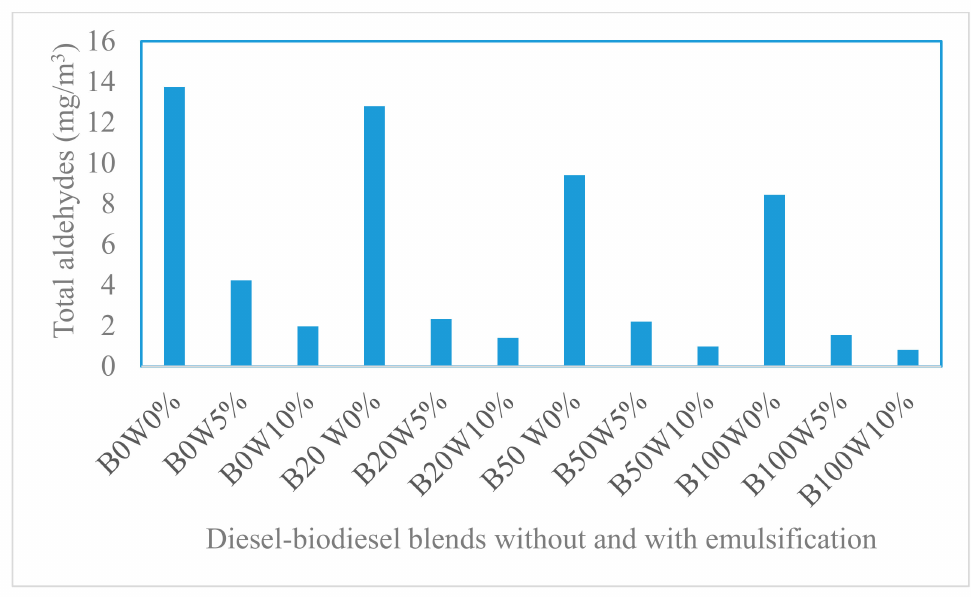
Figure 12. Total aldehydes in exhaust gases of different fuel